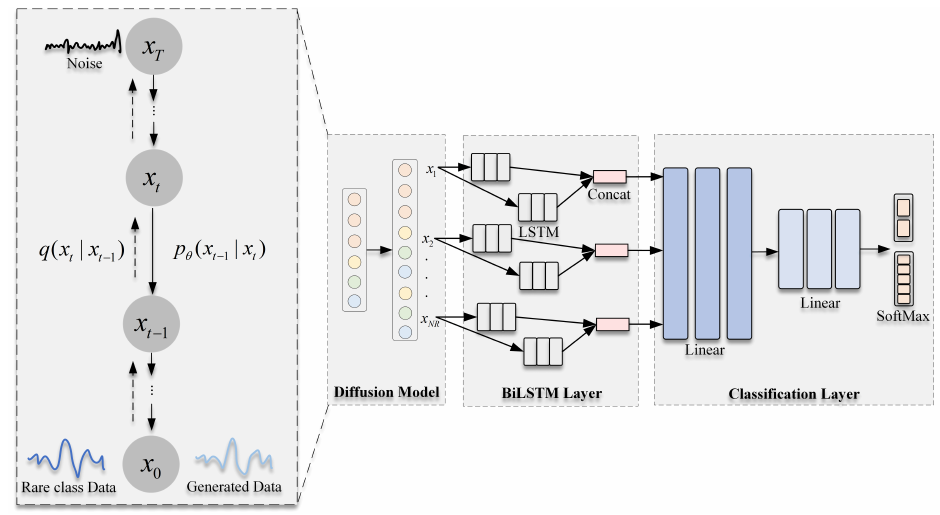
Figure 1. Intrusion detection flow chart based on the diffusion model.